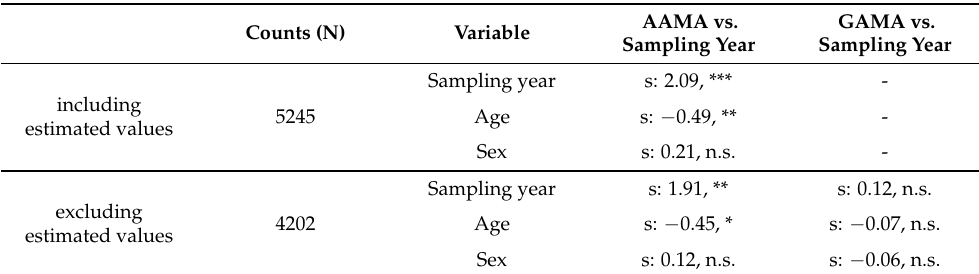
Table 3. Estimated slope (s) and statistical significance of a multiple regression for AAMA and GAMA in µg/L considering age and distribution of sexes as covariates and for populations including (top) or excluding (bottom) studies with values estimated from blood samples. Estimations from blood levels were not performed for GAMA (due to regional variance of estimation factors). ***: p <